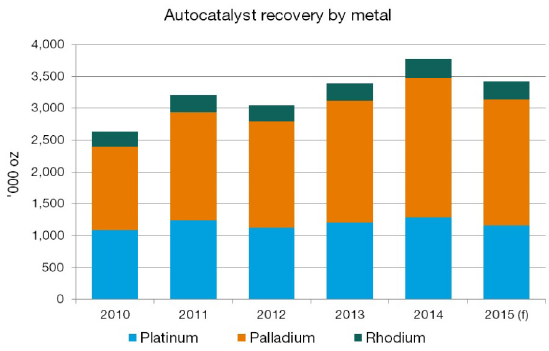
Fig. 2. Recovery of Pt, Pd, and Rh from auto catalysts during years from2010 to 2015